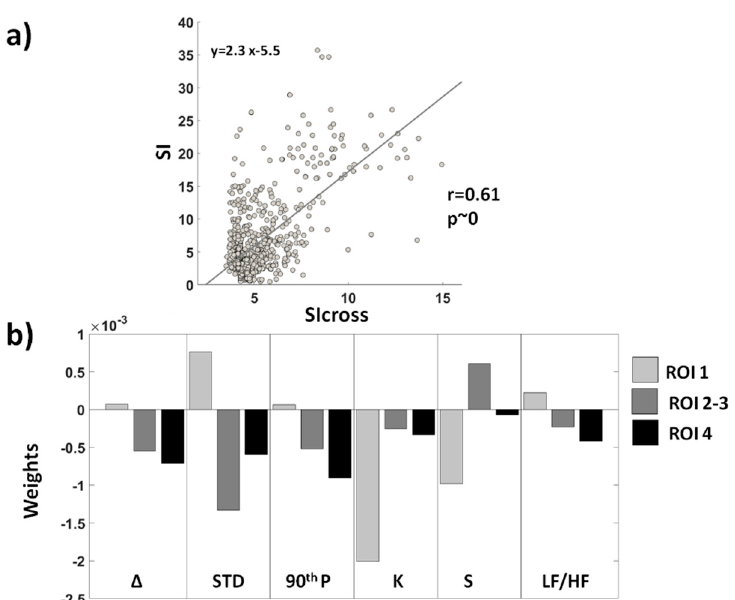
Figure 6. ( a ) Correlation plot between SI and SIcross. The equation of the interpolating line is reported in the top left section of the graph. A good performance of the multivariate analysis is revealed by the correlation score ( r = 0.61, p = ~0); ( b ) weights associated to each z ‐ scored regressor for each ROI. The weights are indicative of the contribution of each model input in the estimation of the SI.